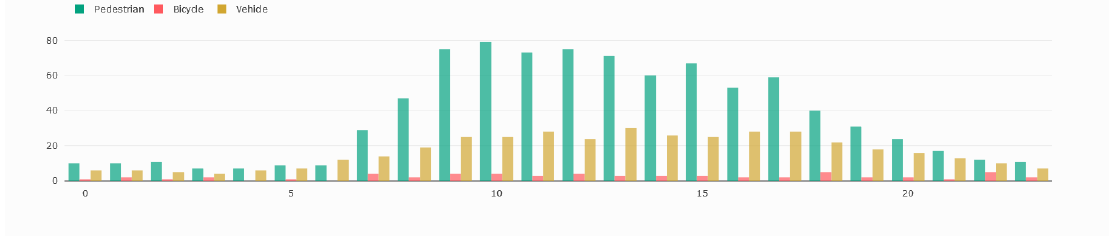
Figure 19. Number of detection pedestrians (green), bicycles (red), and vehicles (yellow) detected hourly on 23 February 2019.